Question: In one sentence, what is this figure communicating?
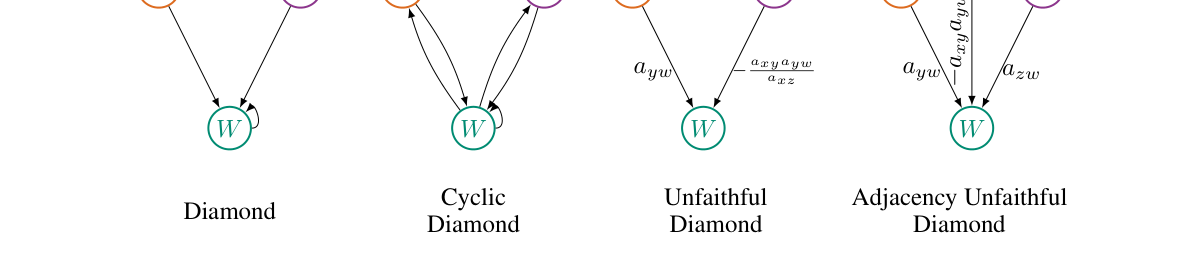
Answer: Summary causal graphs corresponding to the data simulated in Section 5.2. The last two models correspond to an unfaithful distribution.